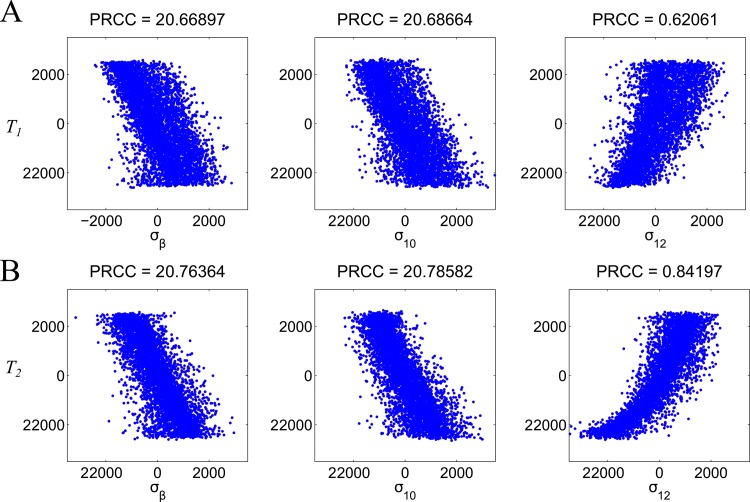
Scatter plots of rank transformed T1
(A) and T2
(B) after 100 weeks versus some rank transformed parameters with statistically significant correlation (|PRCC|>0.5 and p-value <0.01). The title of each subplot shows its PRCC value.